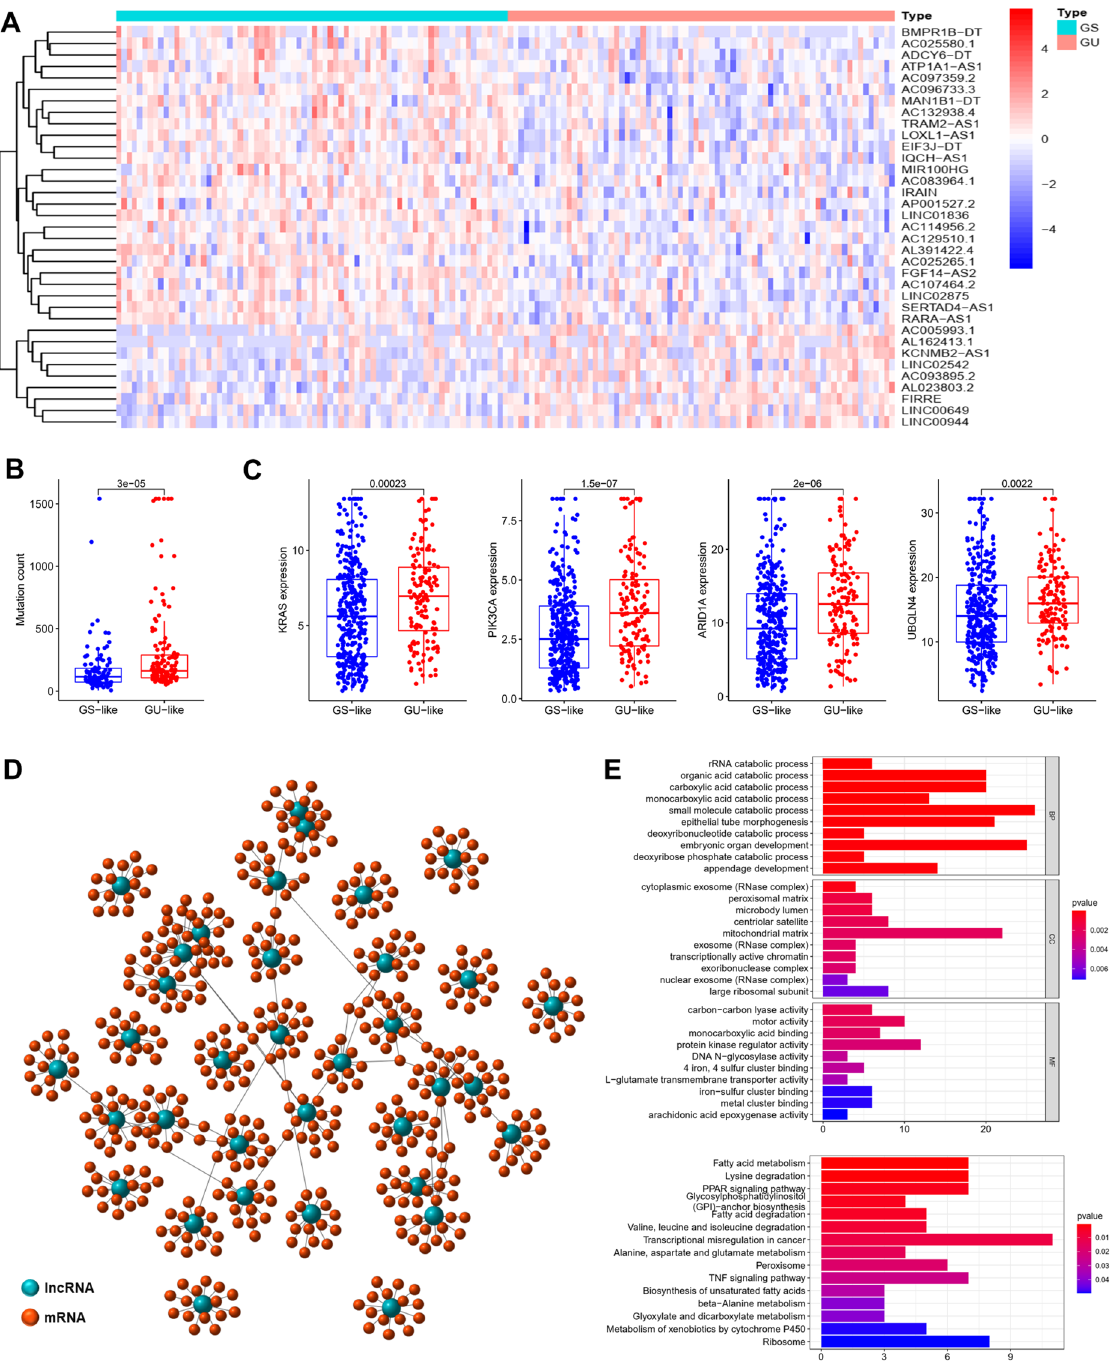
Figure 2. Identification and functional annotations of genomic instability-related lncRNAs in patients with cervical cancer. ( A ) Clustering of 147 cervical cancer patients based on the expression pattern of 35 candidate genomic instability-related lncRNAs. The left blue cluster is GS-like group, and the right red cluster is GU-like group. ( B ) Boxplots of somatic mutations in the GU-like group and GS-like group. Somatic cumulative mutations in the GU-like group are significantly higher than those in the GS-like group ( p < 0.001). ( C ) Boxplots of KRAS, PIK3CA, ARID1A and UBQLN4 expression level in the GU-like group and GS-like group. These genes expression level in the GU-like group is significantly higher than that in the GS-like group ( p < 0.001). ( D ) Co-expression network of genomic instability-related lncRNAs and mRNAs based on the Pearson correlation coefficient. The blue circles represent lncRNAs, and the red circles represent mRNAs. ( E ) Functional enrichment analysis of GO and KEGG for mRNAs co-expressed